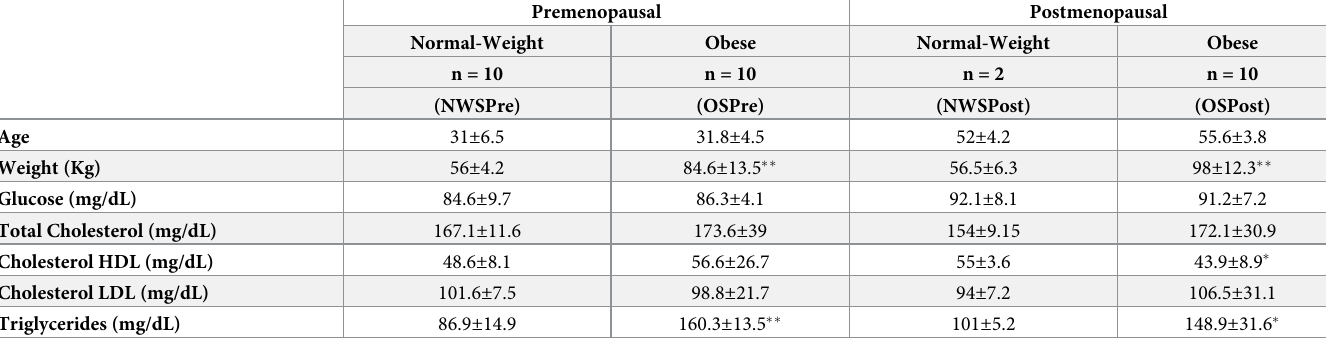
Table 1. Anthropometric and biochemical characteristics of the serum of women with different BMIs and hormonal